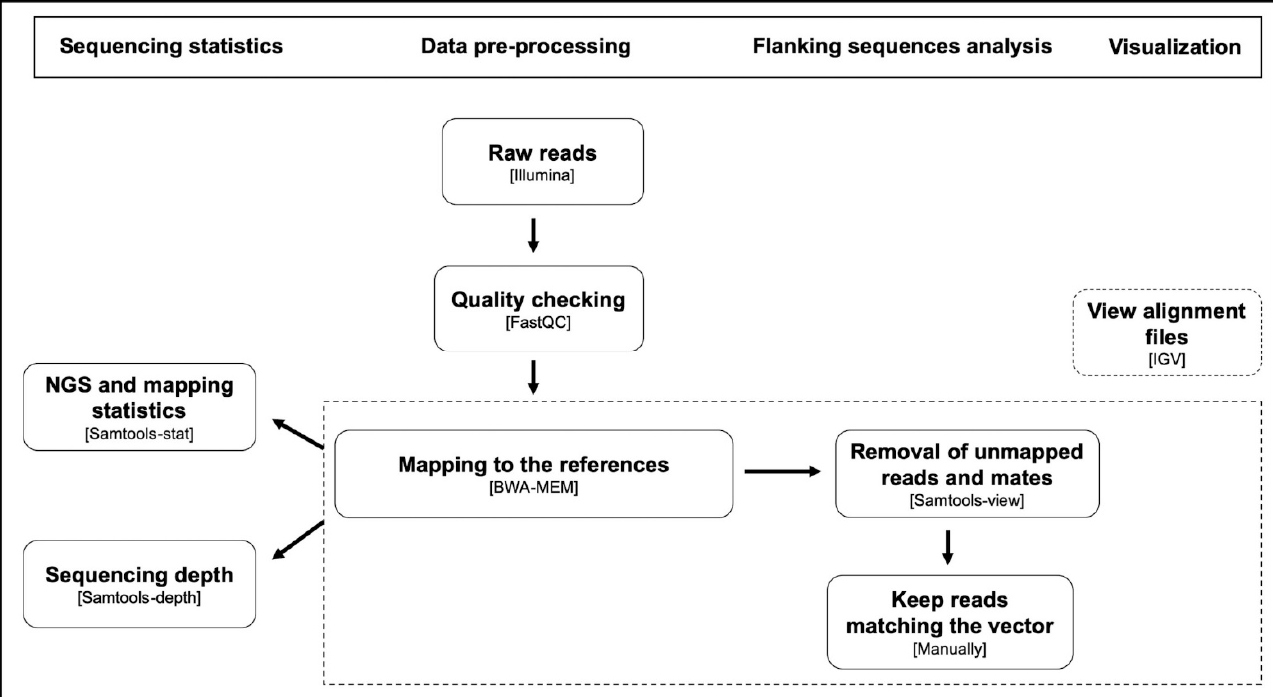
Figure 2. Procedure for finding the insertion sites of transforming DNA in the host genome using short-read NGS data.